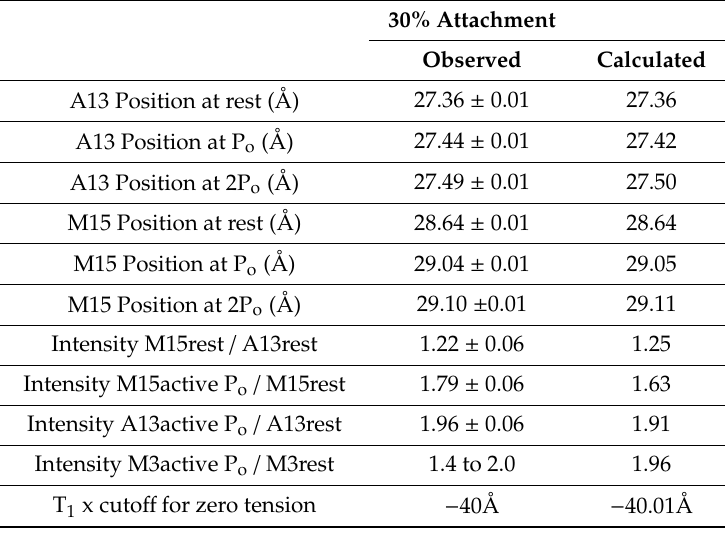
Table 1. Observed and Calculated X-ray values from Model